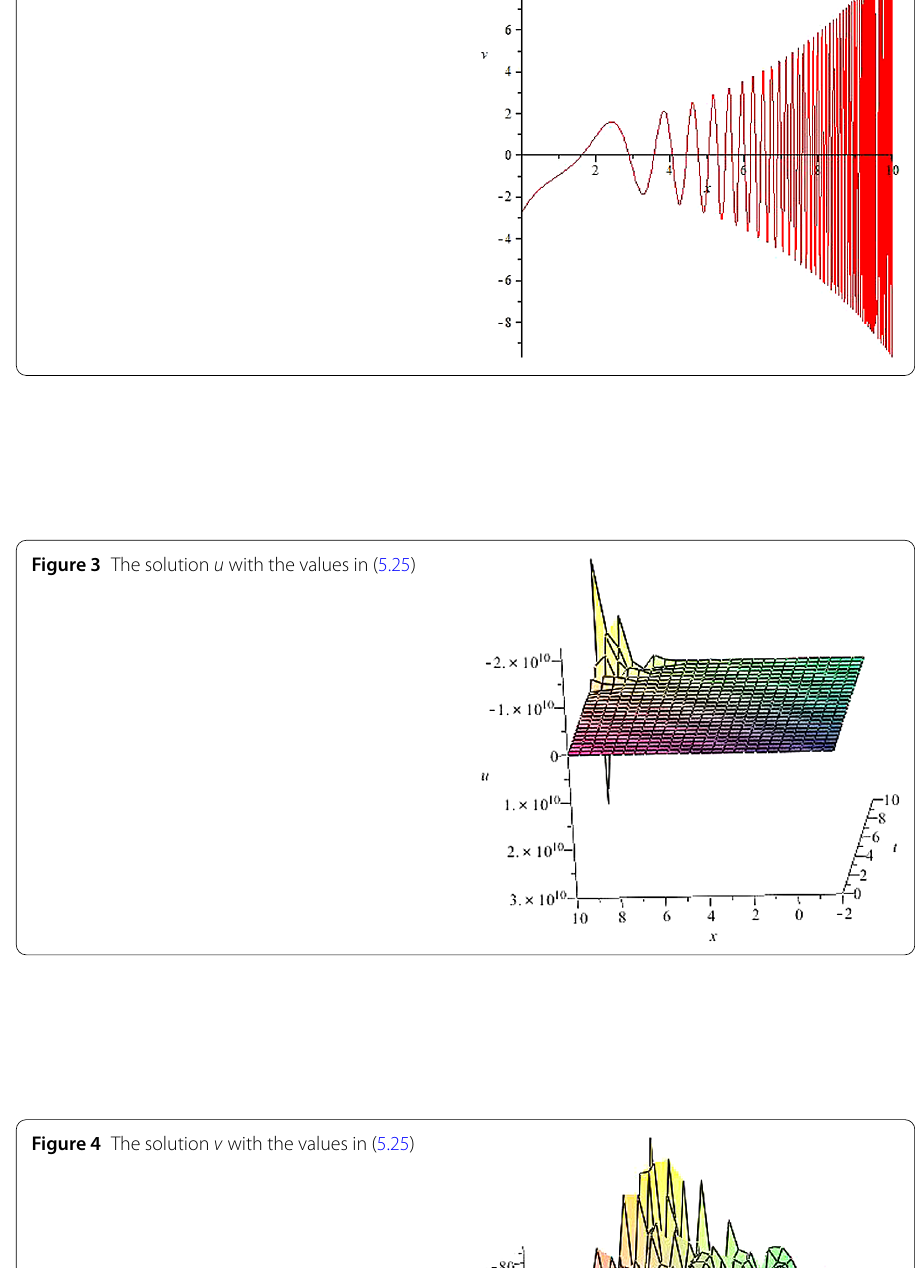
Figure 2 The solution v with the values in (5.25) when t = 0